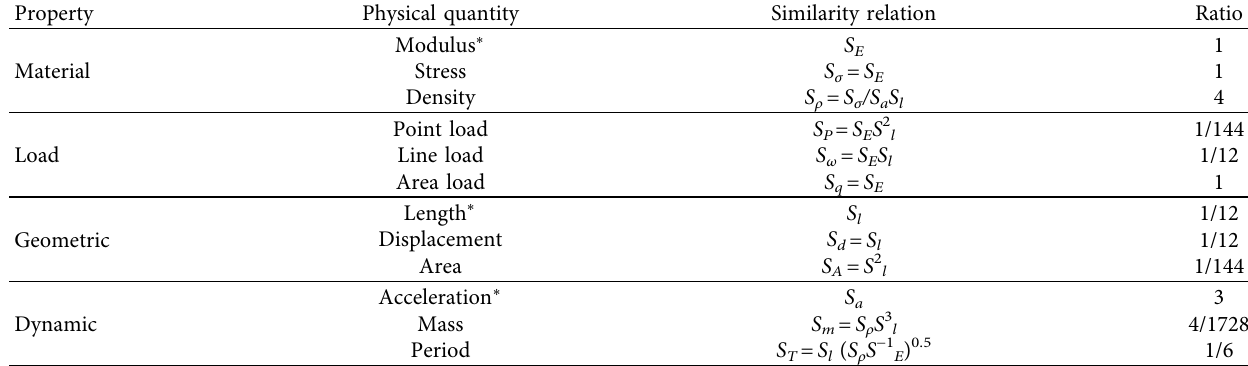
Table 2: Similitude parameters and similarity ratios of the shaking table test [24].